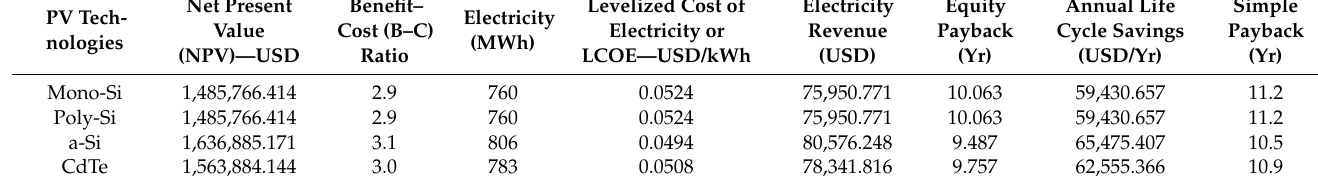
Table 6. Quick comparison of different 600 kW PV technologies in RETScreen.